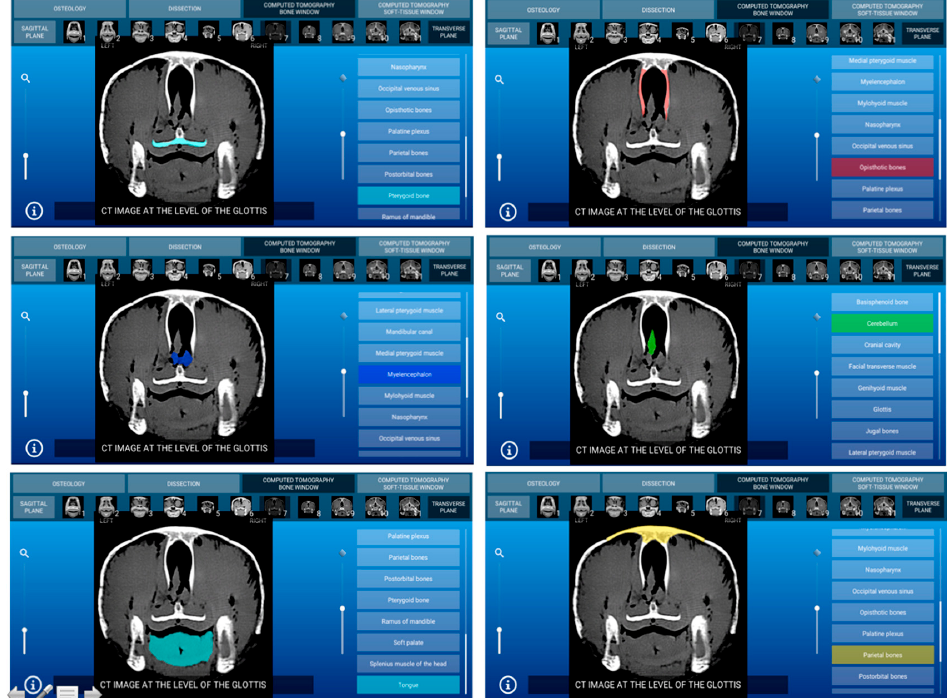
Figure 8. Atlas CT section: an interactive CT bone window transverse image at the level of the glottis is shown in caudal